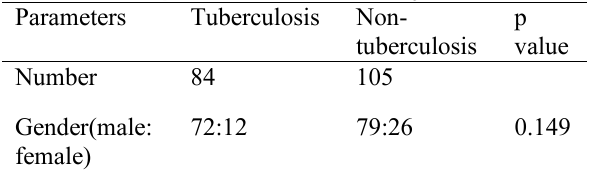
Table 1. Baseline parameters of the